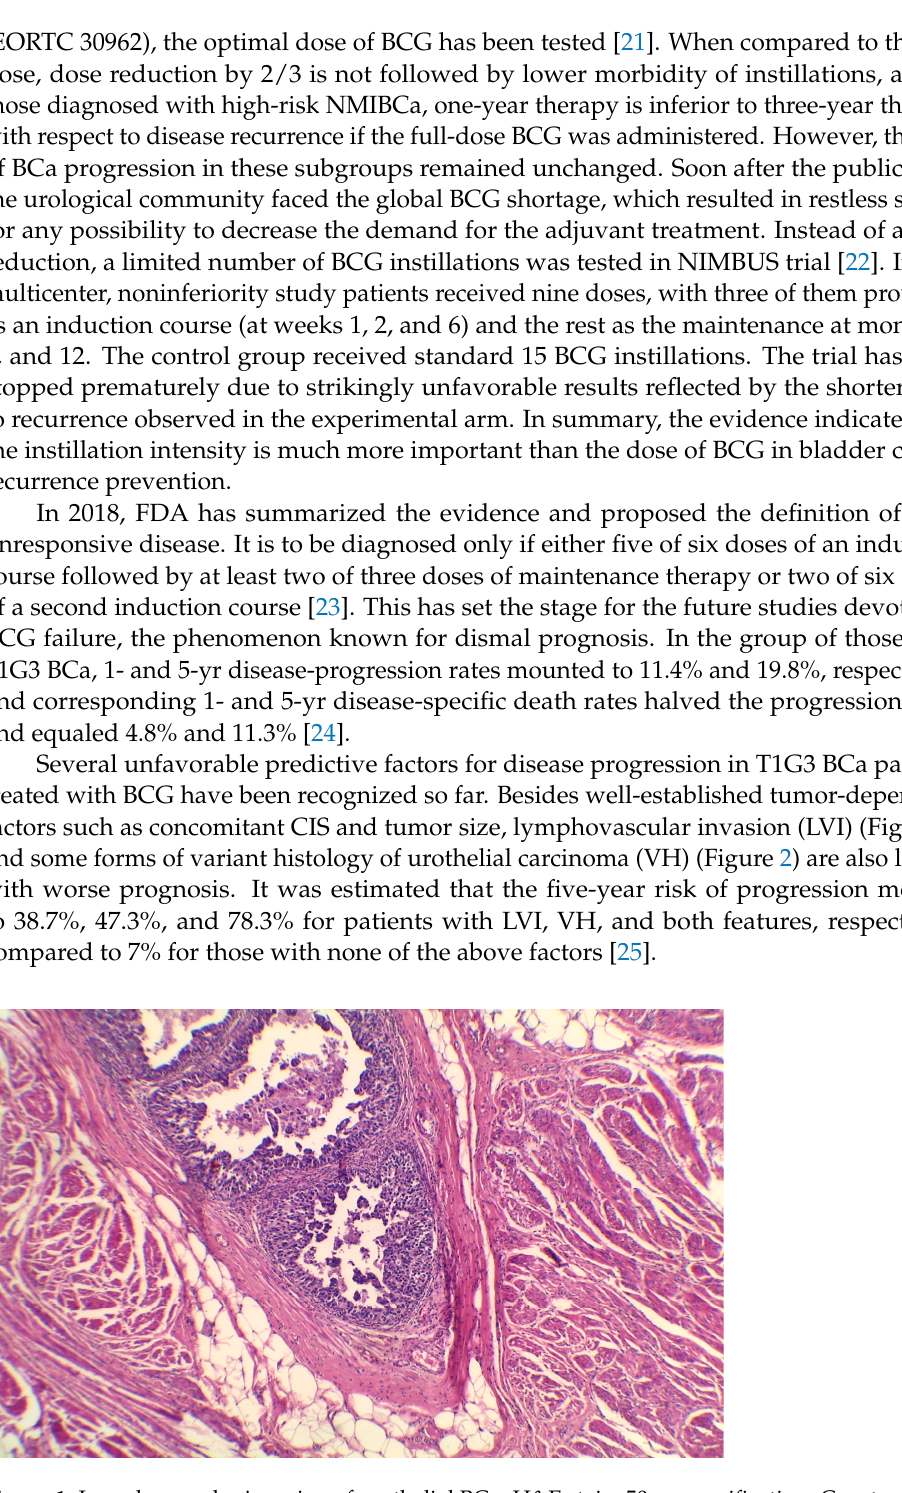
Figure 1. Lymph-vascular invasion of urothelial BCa. H&E stain, 50× magnification. Courtesy of M. Pyzlak, MD, PhD.